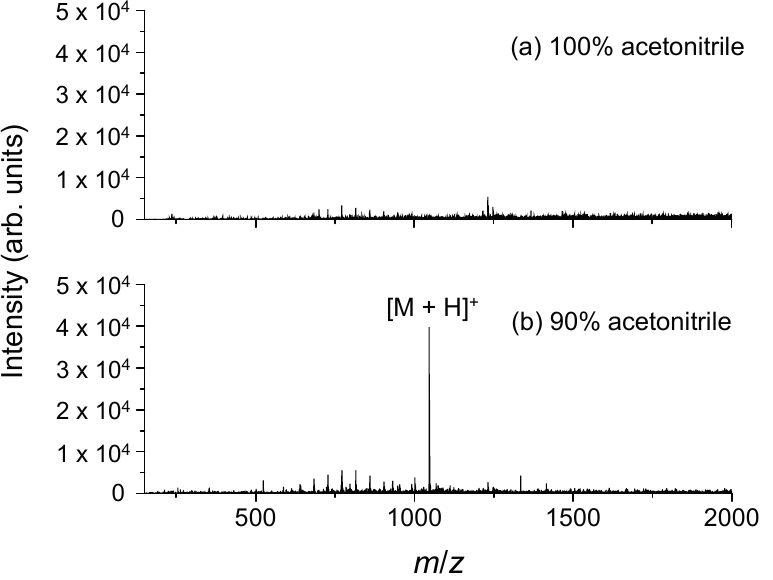
Figure 5. Typical mass spectra of angiotensin II dissolved in ( a ) 100% acetonitrile and ( b ) a 90% acetonitrile aqueous solution upon irradiation with a mid-IR laser at a wavelength of 7.27 µm, which corresponds to the absorption peak of the CH bending vibration mode in acetonitrile. The electric potential of the frit and the capillary temperature were set to 2.5 kV and 270 °C,